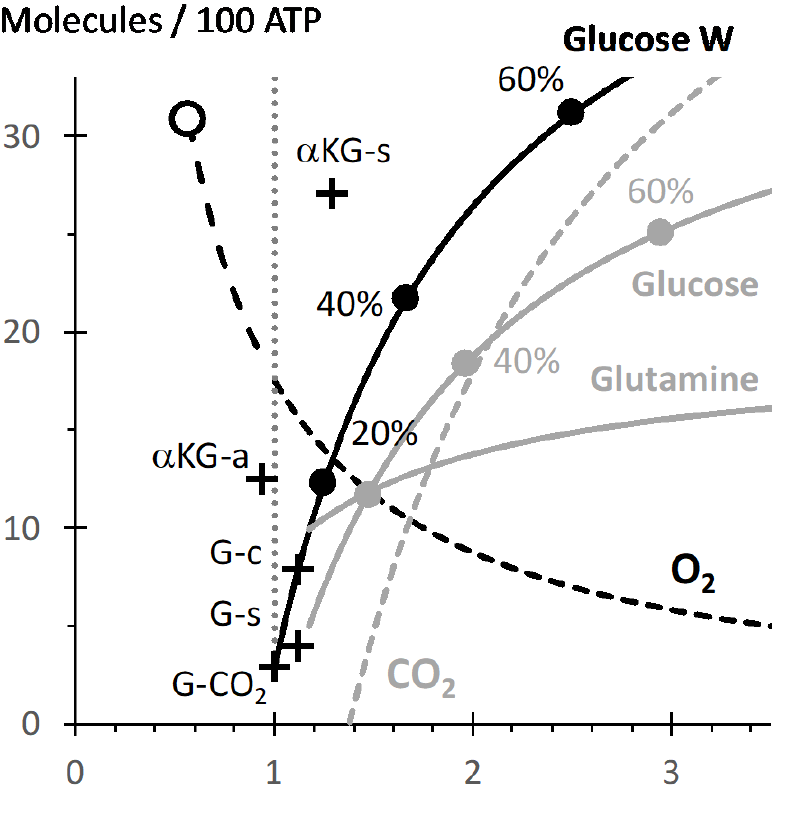
Figure 1. The X -axis indicates the ATP/O 2 ratio expressed as relative to that of full oxidation of glucose into CO 2 (actual value of ATP/O 2 = 5.7), a vertical dotted line highlights this reference value. The Y -axis represents the number of the different substrates required for 100 phosphorylation reactions generating ATP. Crosses represent these values for different oxidative pathways: glucose to CO 2 (G-CO 2, which uses 2.9 glucose), glucose to succinate (G-s) or to citrate (G-c), alphaketoglutarate to oxaloacetate (aKG-a) or to succinate (aKG-s). The black curve (Glucose W) starts from X = 1 and Y = 2.9 (see above) and relates the evolution for glucose utilization as contribution of lactic fermentation increases, dots represent successive increases by 20%. Grey curves represent the consumption of glucose and glutamine releasing alanine and succinate with the aerobic/anaerobic pathway presented in Supplementary Material 4 and 5. The dashed grey curve represents the CO 2 flux in this same pathway but with inverse ordinates: it becomes positive when net fixation of CO 2 occurs (X = 1.4). The dashed black curve (hyperbolic) represents the oxygen consumption. The longer dashes, indicate values starting from oxidation of succinate into malate SDH reaction (empty dot X = 0.57) to that of glucose (X = 1, Y = 17.5O 2 ) and therefore represent the range of values for oxygen consumption expected from reoxidation of succinate when accumulated (see text).